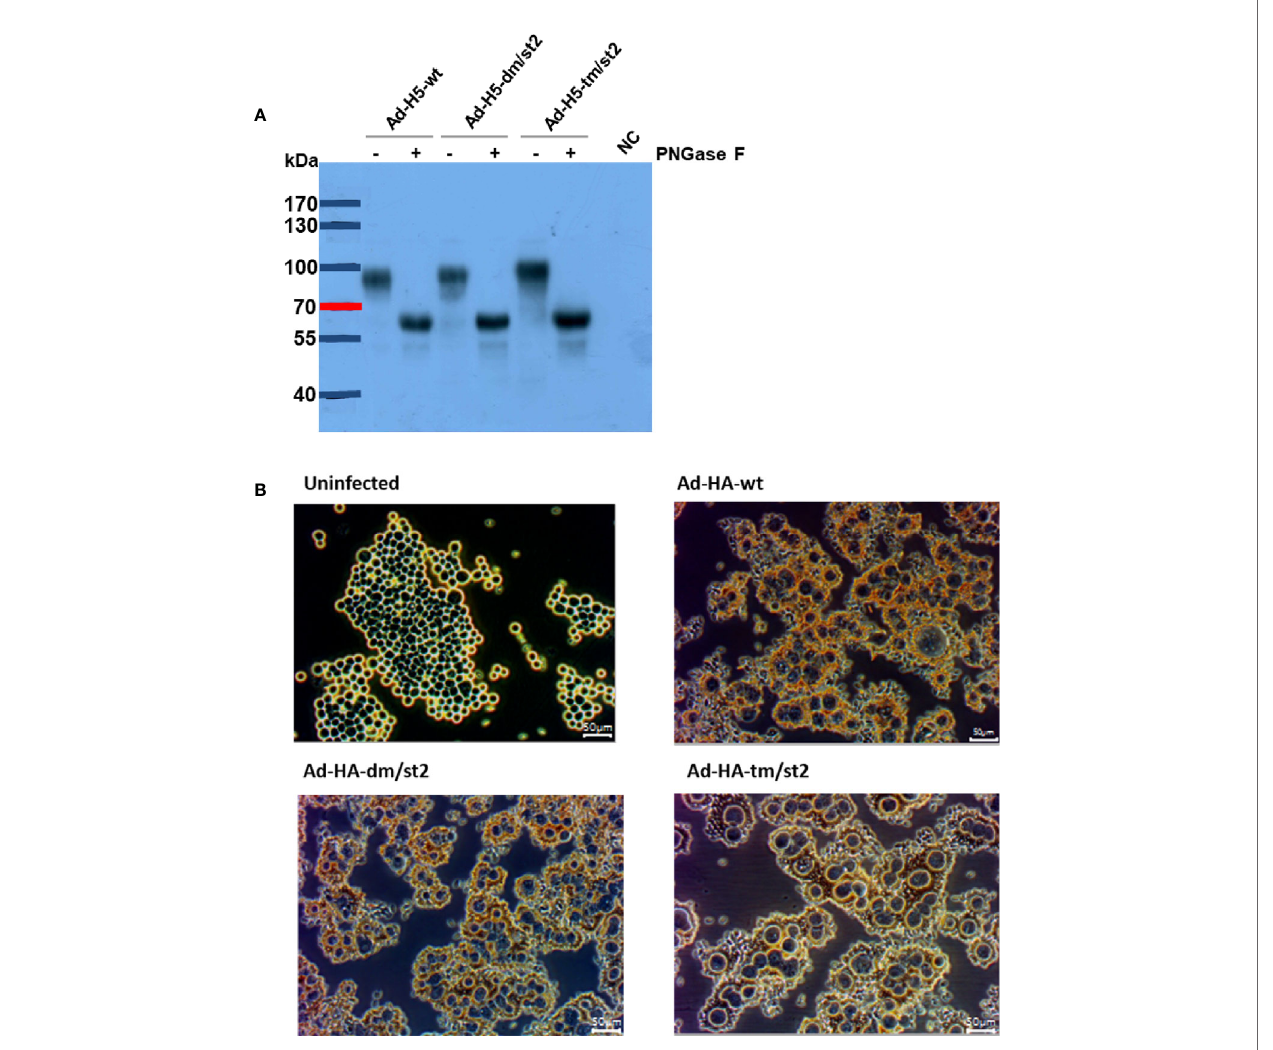
FIGURE 2 | Characterizations of adenovirus vector encoding the full-length H5 gene with a combination of glycan-masking and glycan-unmasking HA antigen design. (A) WT and mutant H5 proteins expressed in adenovirus vector-infected 293A cells were con fi rmed by western blotting with anti-H5 antibody. (B) RBCs absorbed on adenovirus-infected cells were observed by